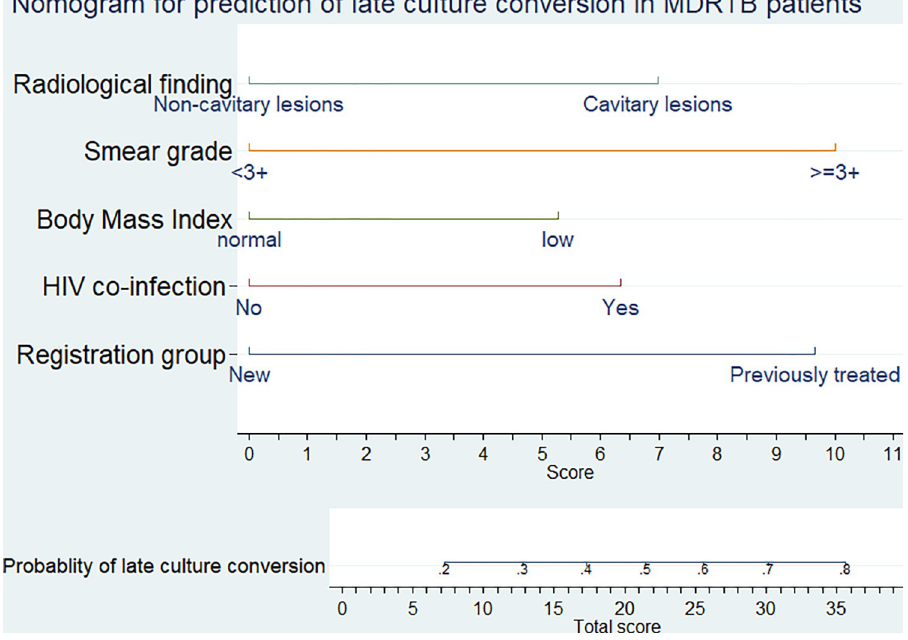
Fig 3. Nomogram for the prediction of late culture conversion among MDR-TB patients in North West Ethiopia, September 2010 to July 2020.